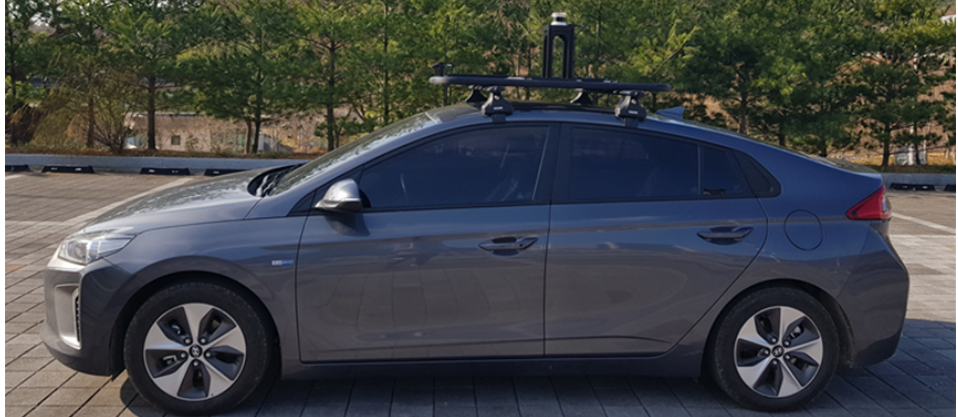
Figure 11. Real-world vehicle for data collection and testing. Table 2. Three-axis acceleration standard deviation and median according to driving